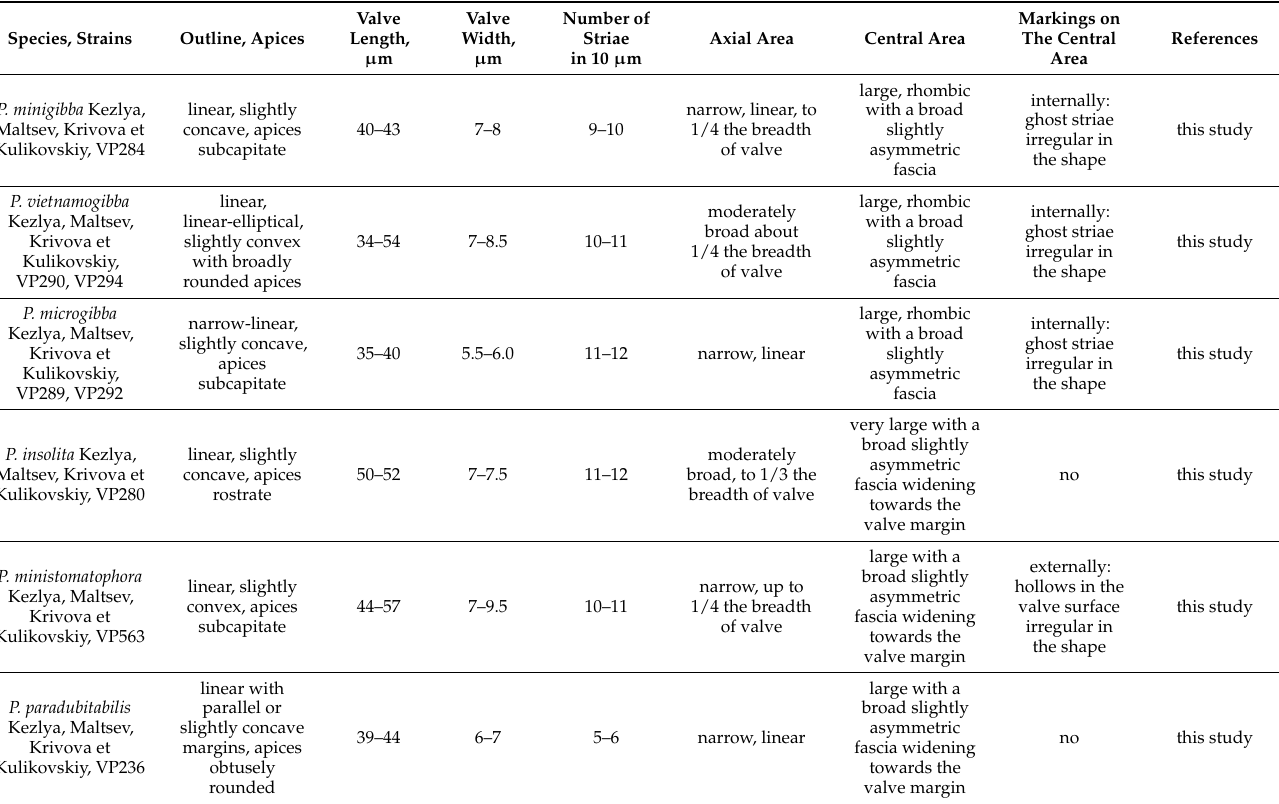
Table 2. Comparison of species and strains of Pinnularia from studied material with similar